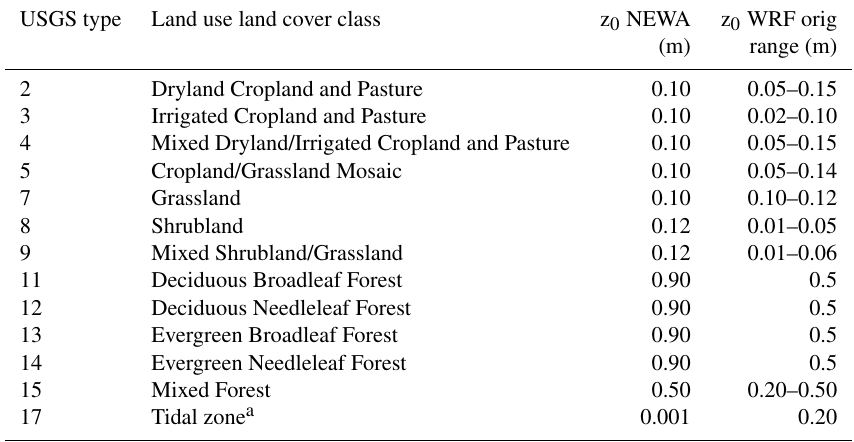
Table B1. Lookup table for the surface roughness length as a function of the USGS land use category in the NEWA and default NCAR WRF model configuration. Only values changed from the default are